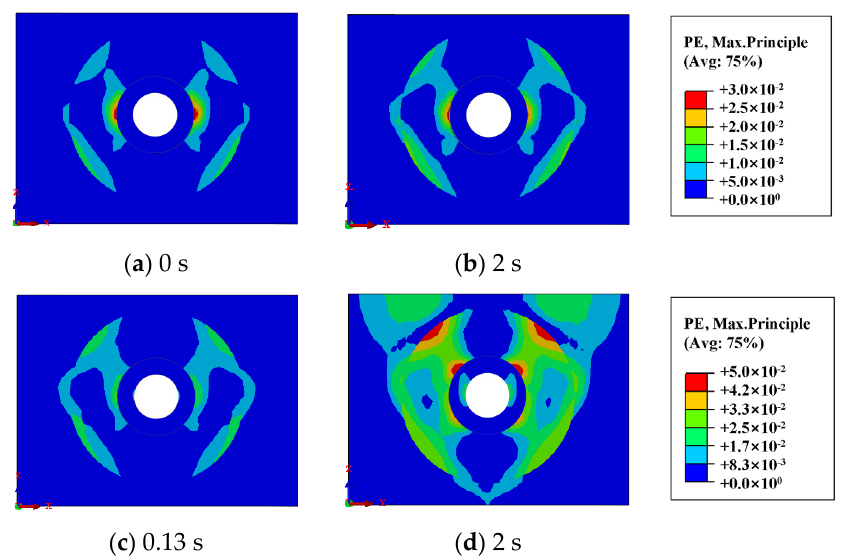
0 s and 2 s and the impact load of ( c,d ) the weight fall at 0.13 s and 2 s, respectively.